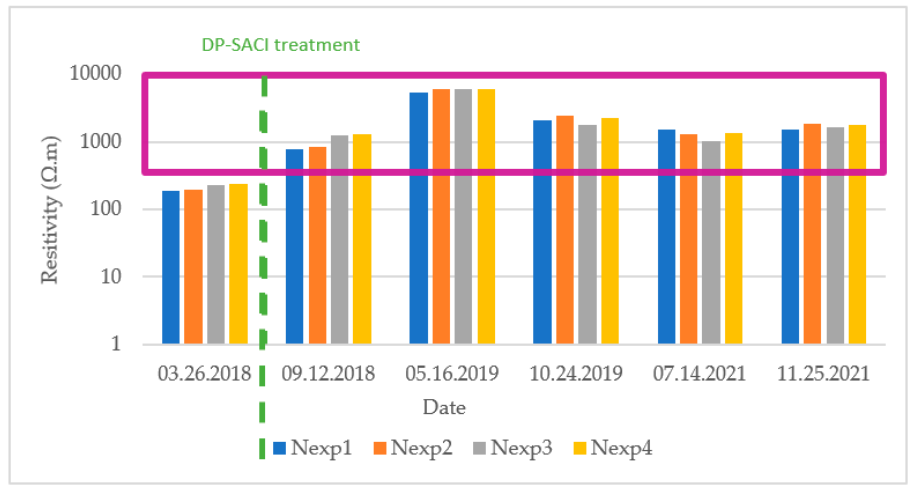
Figure 10. Resistivity evolution over the treated area after DP-SACI